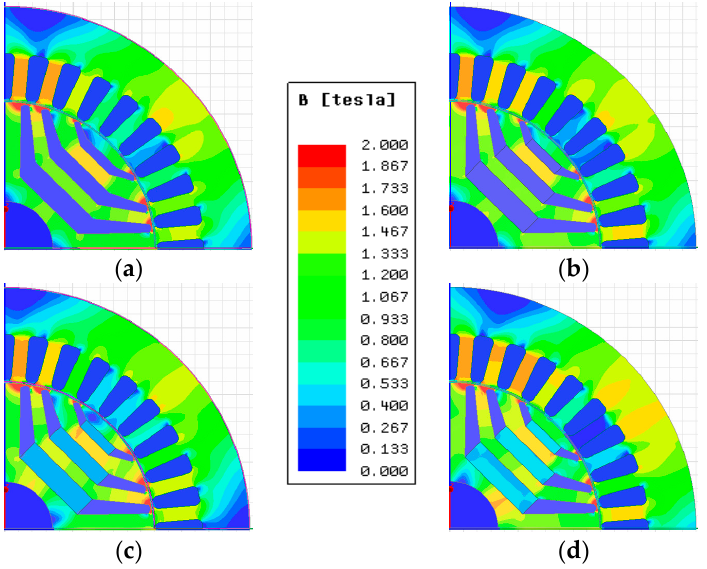
Figure 7. Flux density distribution of the four prototypes at rated current and optimal current angles.